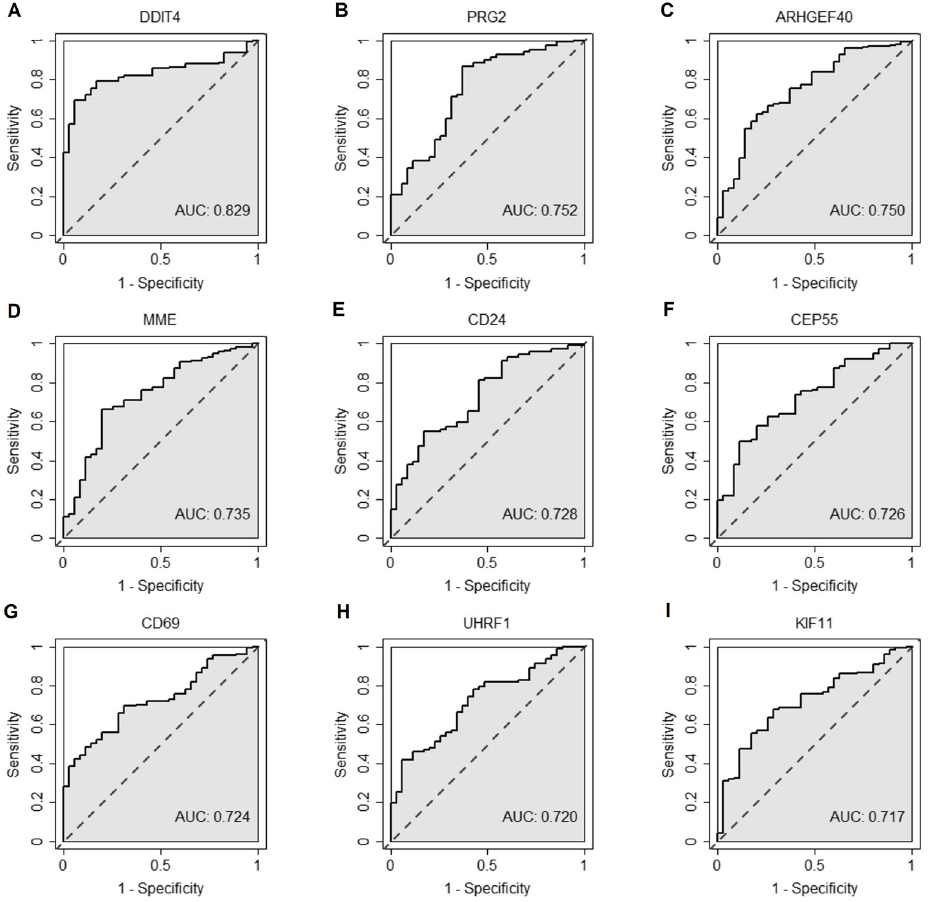
Figure 3. Receiver operating characteristic curves of top performing differentially expressed genes in prognostic prediction of pediatric septic shock. A , DDIT4; B , PRG2; C , ARHGEF40; D , MME; E , CD24; F , CEP55; G , CD69; H , UHRF1; I , KIF11. AUC: area under the receiver operating characteristic